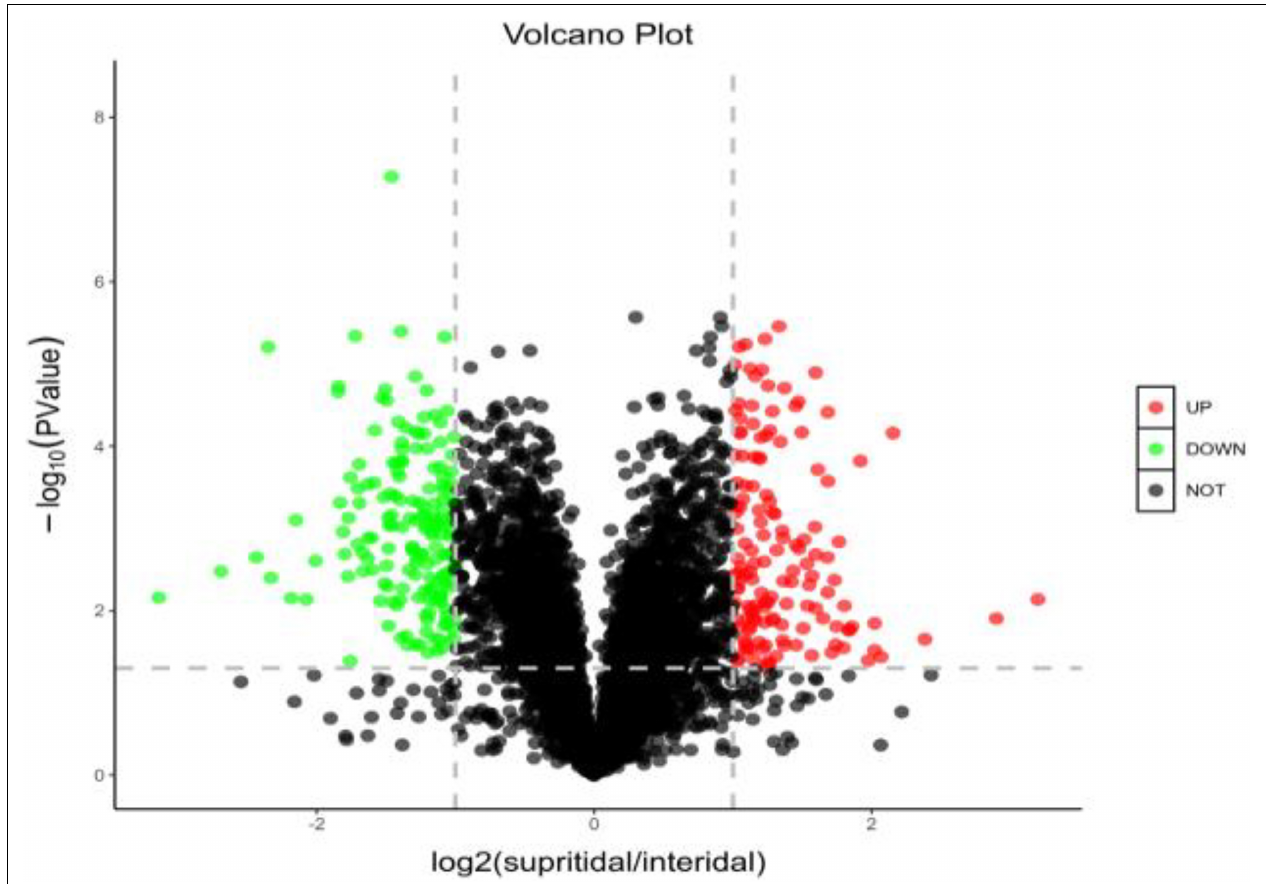
FIGURE 4 | Distribution and abundance distribution of up- and downregulated proteins of S. salsa in different habitats; red indicates significantly upregulated differential proteins; green indicates downregulated differential proteins; black indicates no significant difference in